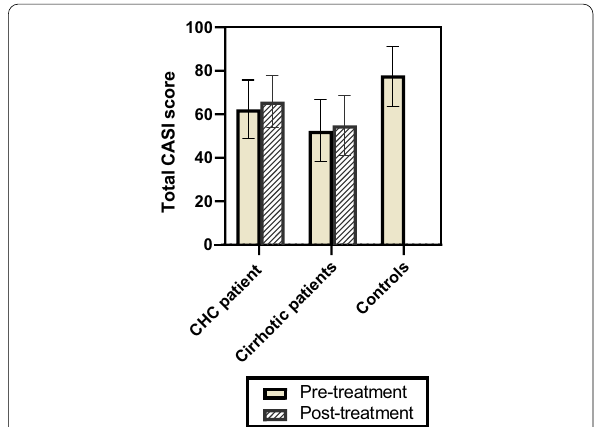
Fig. 1 Total CASI score among the studied groups